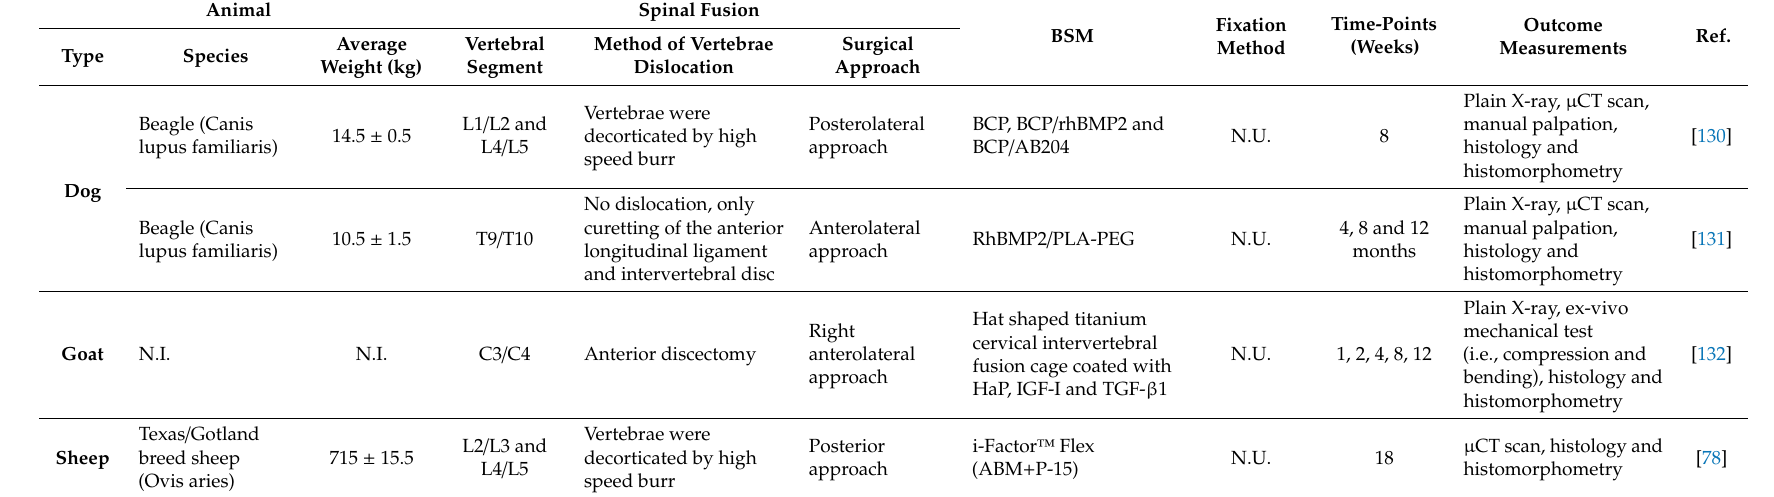
Table 4. Selection of preclinical spinal fusion studies for biological BSM